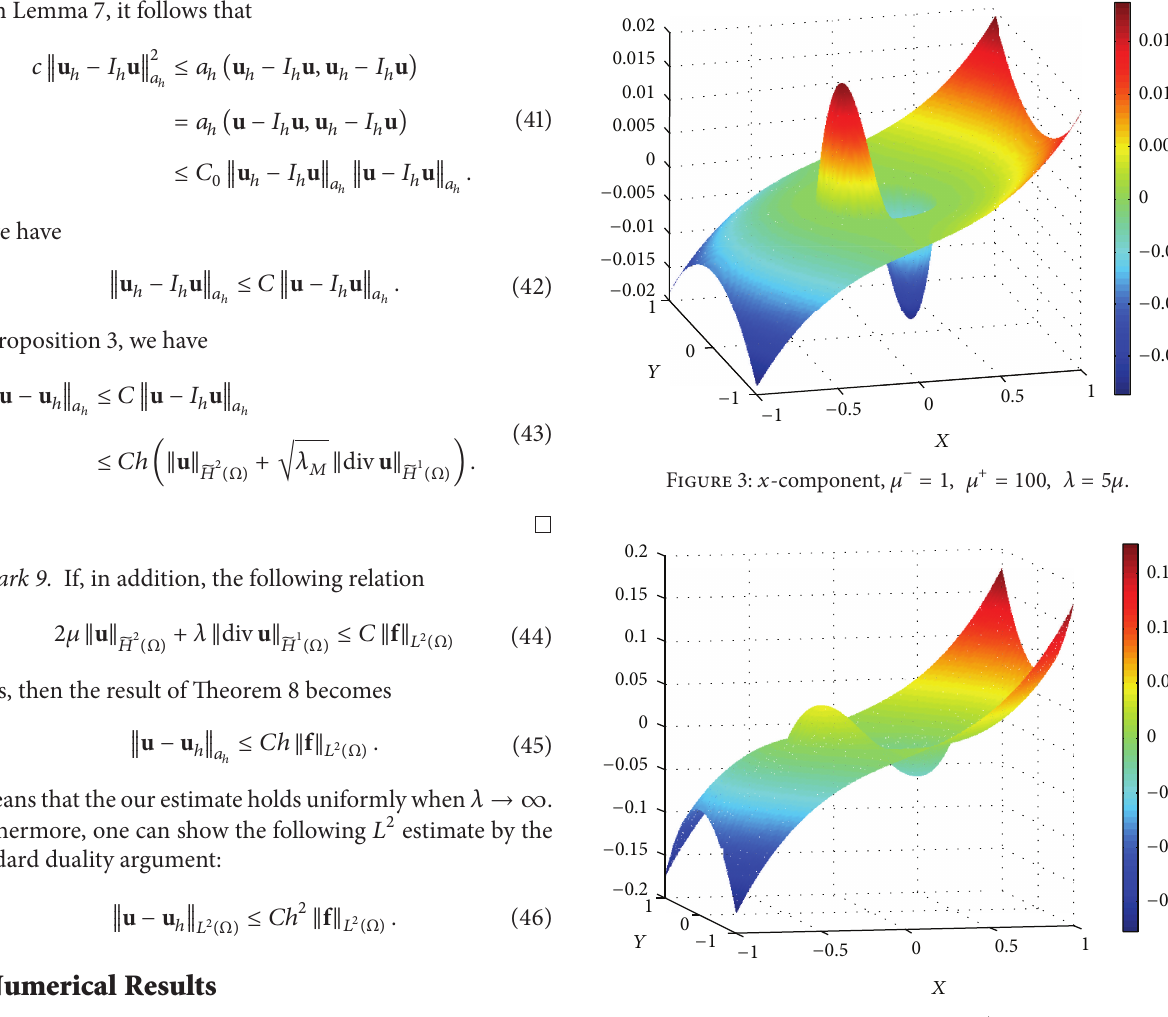
Figure 4: 𝑥 -component, 𝜇 − = 1, 𝜇 + = 10, 𝜆 = 5𝜇